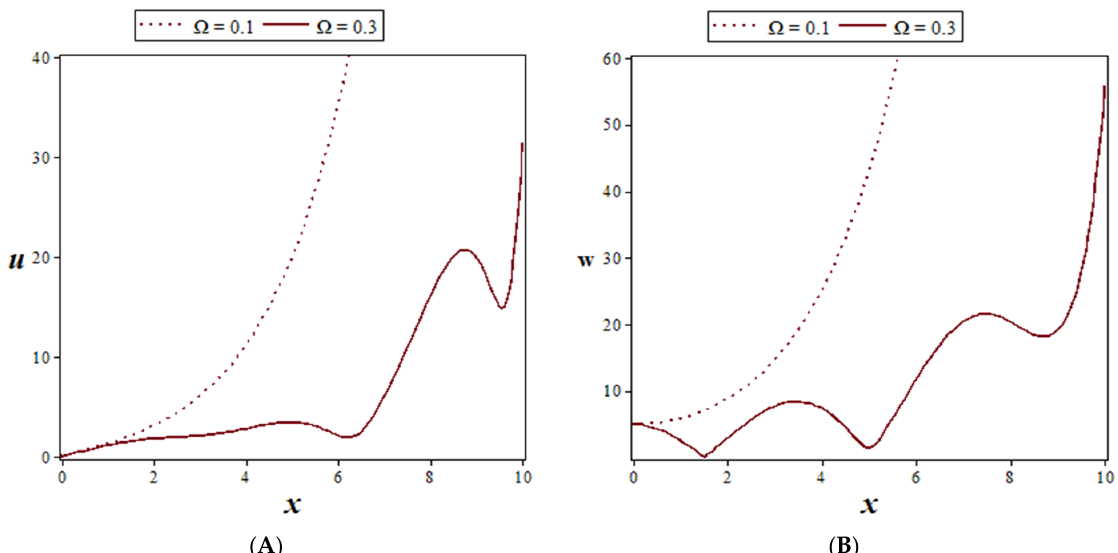
Figure 8. ( A , B ) Displacement components’ perturbation u ( x ) and w ( x ) for the complex circular frequency ω min = − 0.258 at K max = 0.25649 (wave number) when ε 3 = − 7.234118786 × 10 − 36 and with two small values of the rotation parameter Ω .